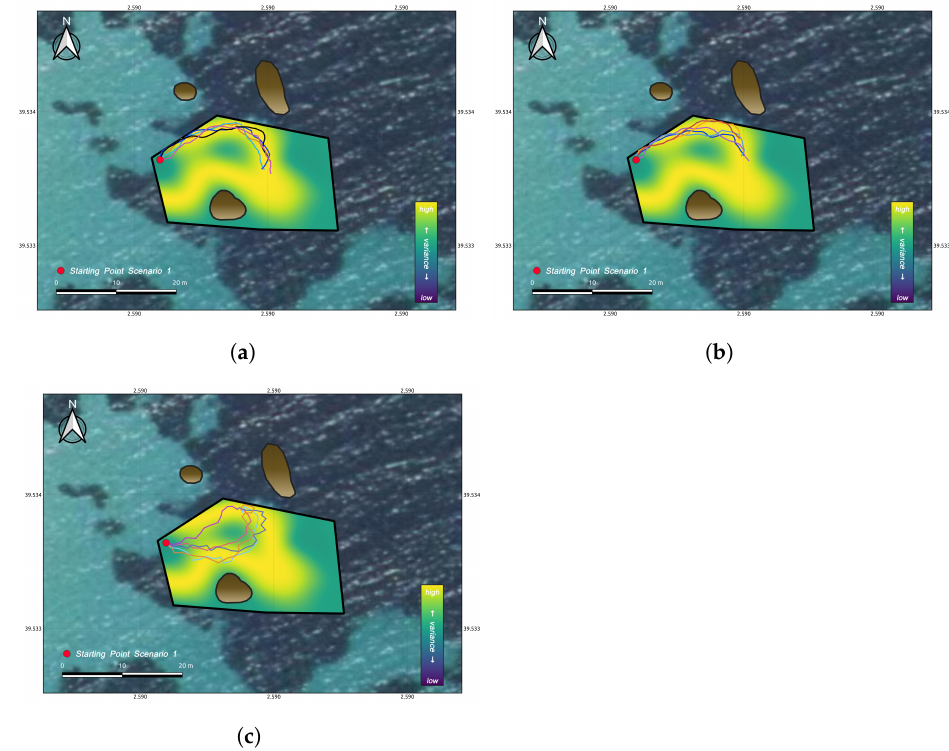
Figure 5. Five best paths Area 1-Scenario 1. ( a ) Genetic; ( b ) Random; ( c ) S-B.